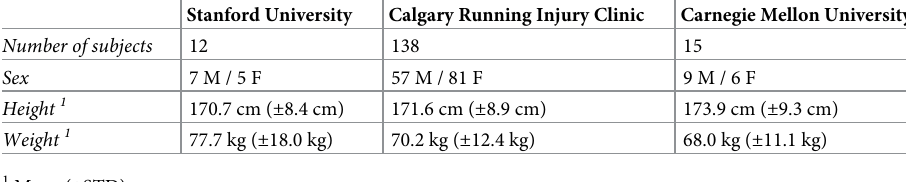
Table 1. Summary demographics for participants included in each